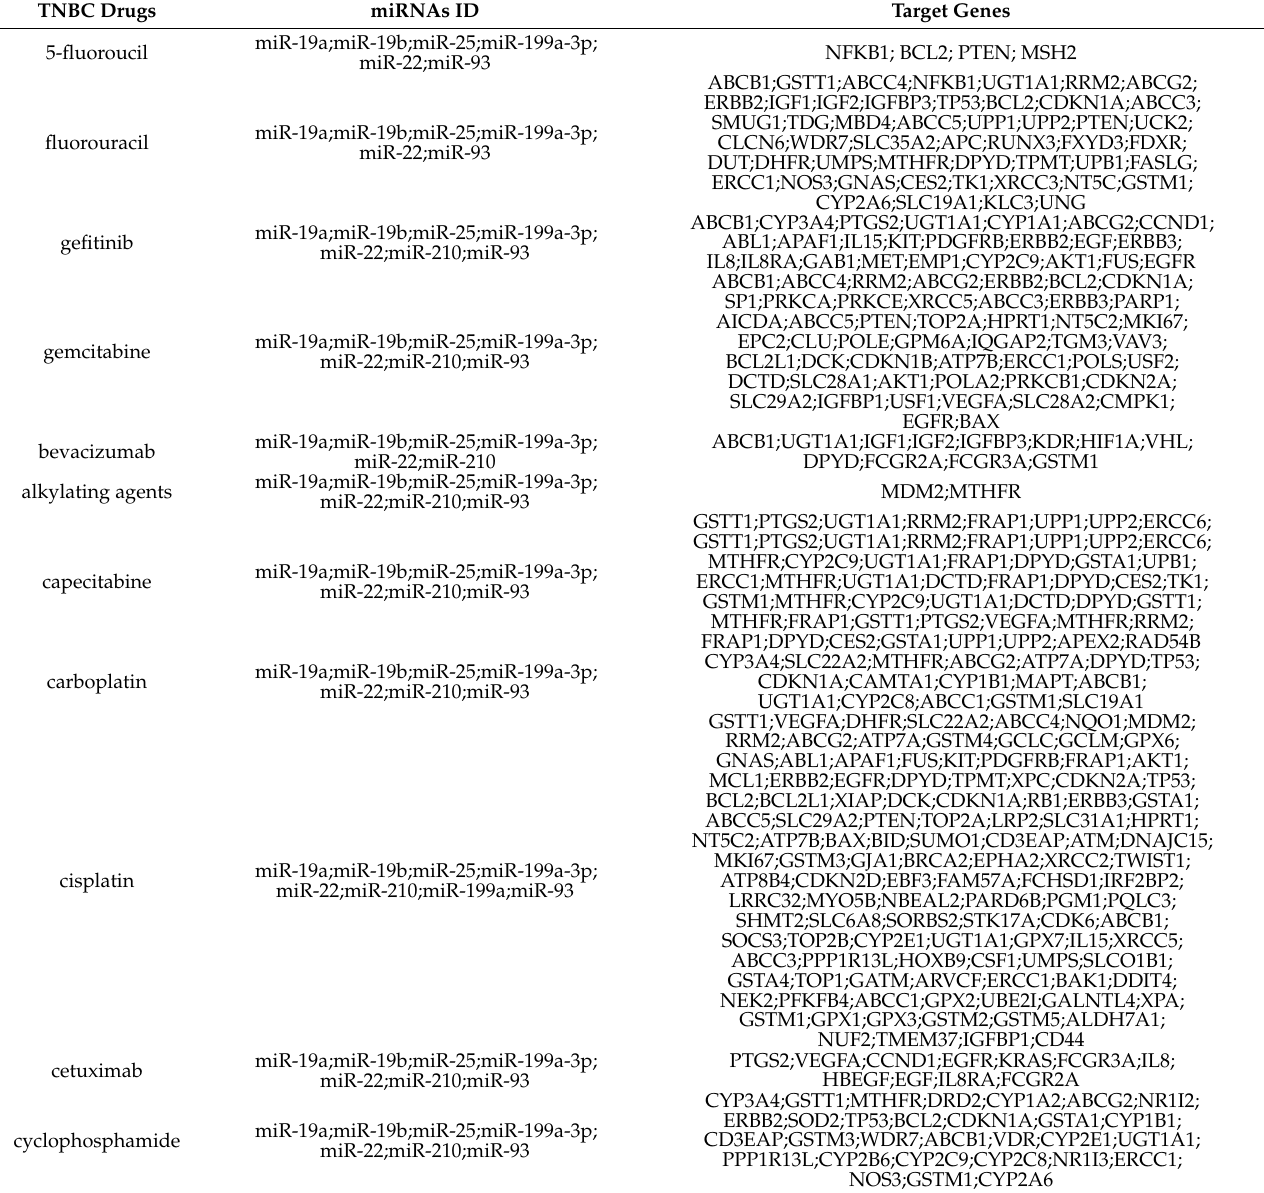
Table 4. Significant TNBC miRNAs and their respective target genes associated with TNBC